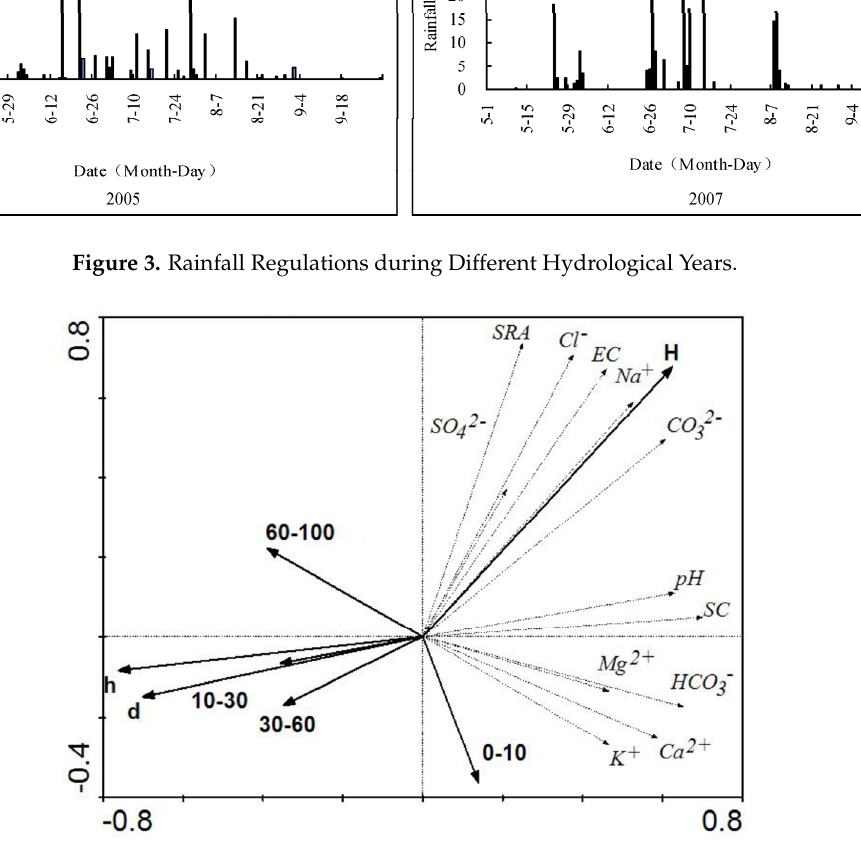
Figure 4. RDA 2D Ordination Diagram for Soil Salinization and Environment Factors in wet year.